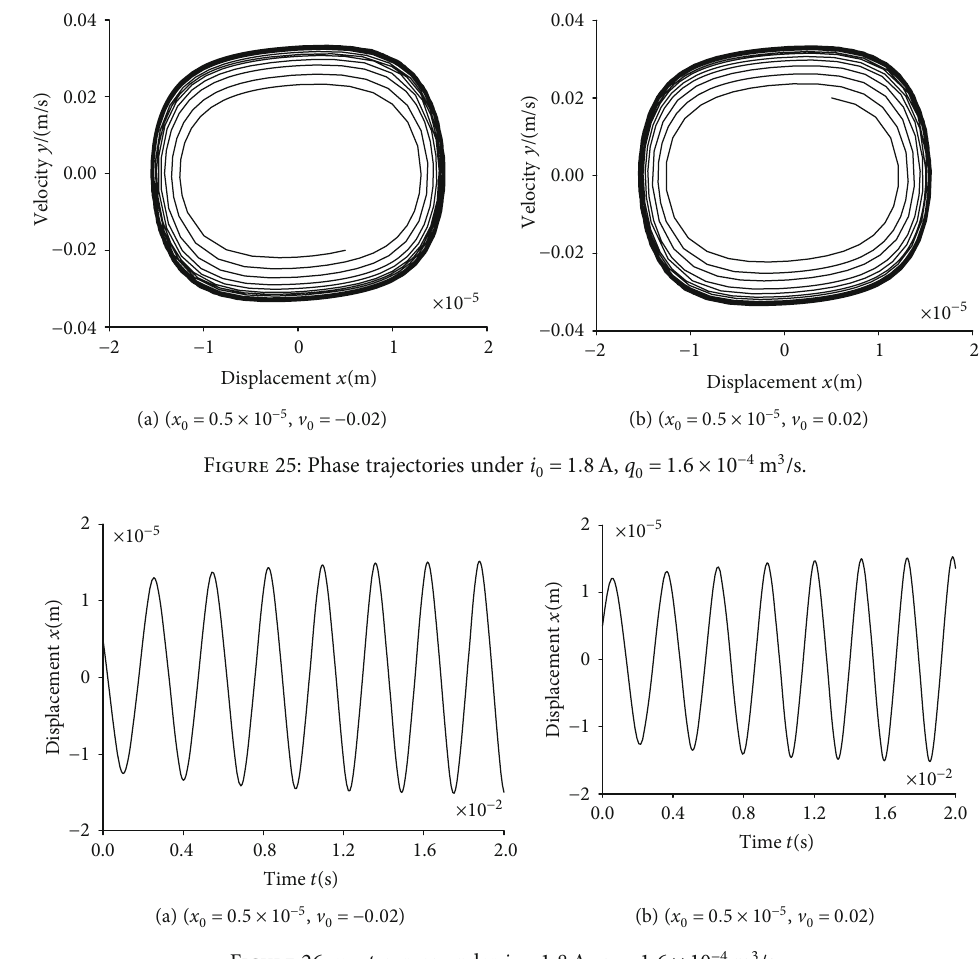
Figure 26: x − t curves under i